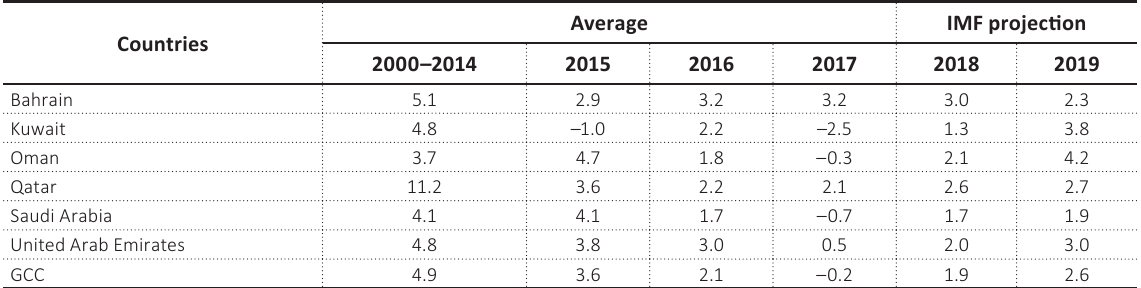
Table 1. Growth in real GDP